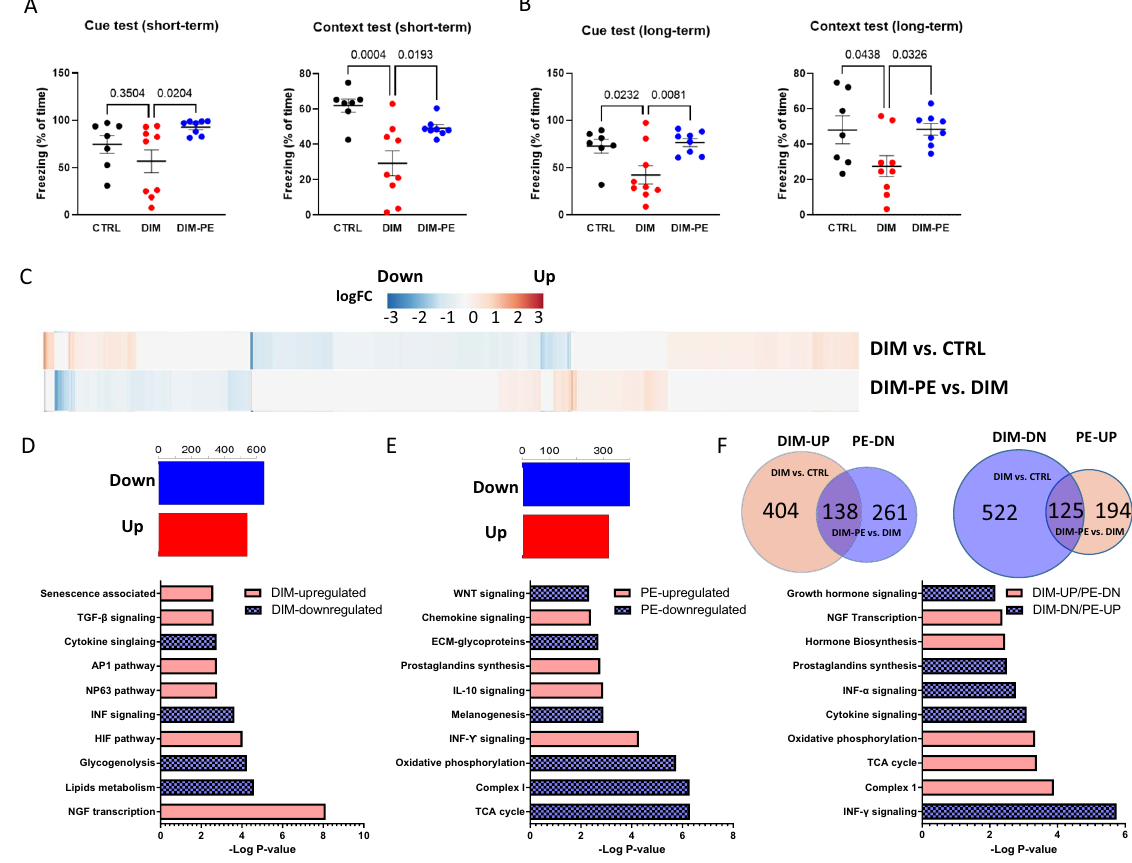
Figure 3. The effect of high fat diet and physical exercise intervention on learning and memory and transcriptional assessment of hippocampus in response to diet and physical exercise. ( A ) Short-term memory assessed by fear conditioning, % of freezing in the cue test and context test. ( B ) Long-term memory assessed by fear conditioning, % of freezing in the cue test and context test ( C ) Heatmap of genes differentially regulated by high fat diet (DIM vs. CTRL) compared with the same genes regulated by physical exercise (DIM-PE vs. DIM). ( D ) Number of upregulated genes and downregulated genes in DIM mice compared to CRTL mice and top 10 GO enrichment pathway analysis of DEGs regulated by high fat diet. ( E ) Number of upregulated genes and downregulated genes in DIM-PE mice compared to DIM mice and top 10 GO enrichment pathway analysis of DEGs regulated by PE intervention. ( F ) Venn diagrams of total number of significantly upregulated and downregulated genes in high fat treated mice with or without PE intervention and top 10 GO enrichment pathway analysis of DEGs regulated by high fat diet and rescued by PE intervention. Data represents mean ± SEM. n = 7–9 per group for ( A ) and ( B